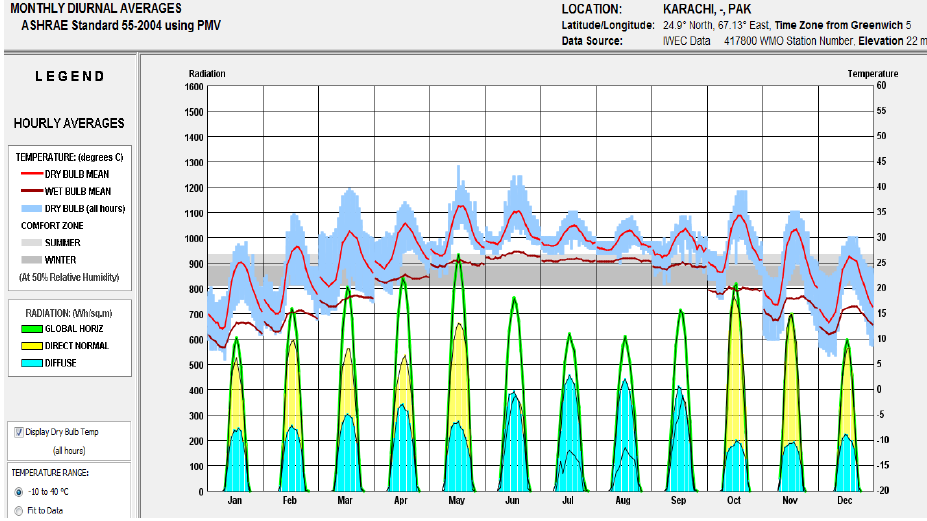
Fig. 4. Monthly diurnal temperature averages, Karachi, Pakistan. Source: Climate